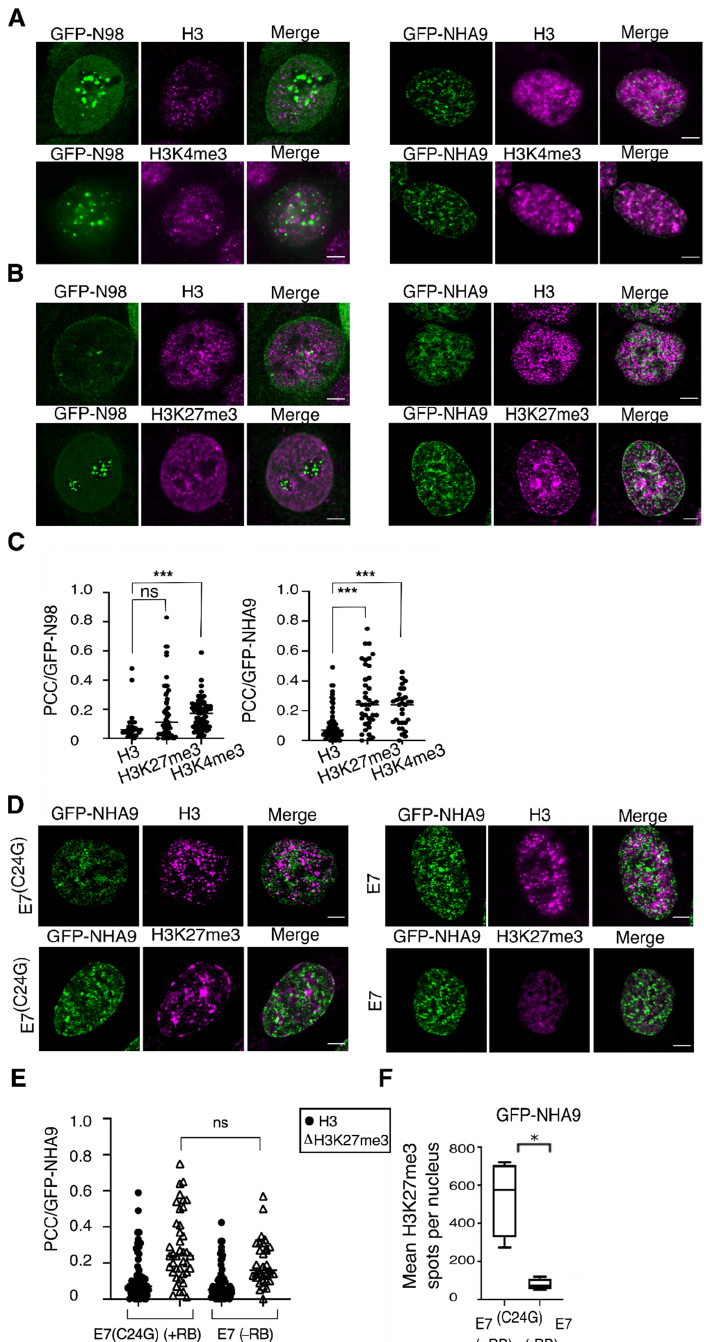
Figure 3. NUP98–HOXA9 foci associate with H3K4me3, and H3K27me3 marks and alters H3K27me3 distribution. ( A ) HCT-116 cells transiently expressing GFP-NHA9 (green) and GFP-N98 (green) were respectively stained for histone H3 (magenta) and the H3K4me3 mark (magenta), as well as ( B ) for H3 (magenta) and H3K27me3 (magenta). Shown are representative confocal images. Scale bars, 5 µ m. ( C ) Pearson’s correlation coefficients (PCCs) GFP-NHA9 as well as GFP-N98 with H3K27me3 and H3K4me3. Histone 3 was used for normalization. ( D ) The effect of GFP-NHA9 on H3K27me3 patterning is neglected in cells expressing E7 and lacking RB but not in E7(C24G) expressing cells. The pattern of H3 is similar in both backgrounds. ( E ) PCC values regarding GFP-NHA9 with H3K27me3 and H3 in E7(C24G) and E7 expressing cells. ( F ) Quantitative measurement of H3K27me3 spots per nucleus in E7(C24G) and E7 cells expressing GFP-NHA9. The number of experiments was: n = 3; *** p < 0.001, * p < 0.05, ns, p not significant, t -test,